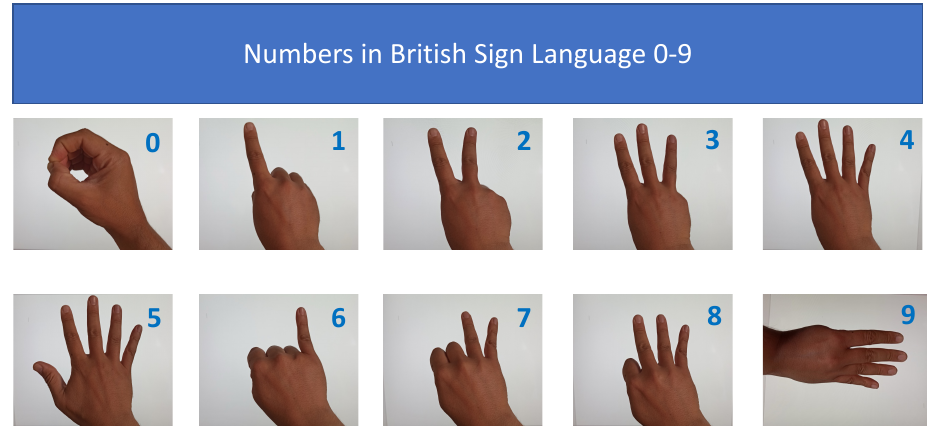
Figure 10. British Sign Language Hand Gestures. Here are some British Sign Language Pose Signs in Figure